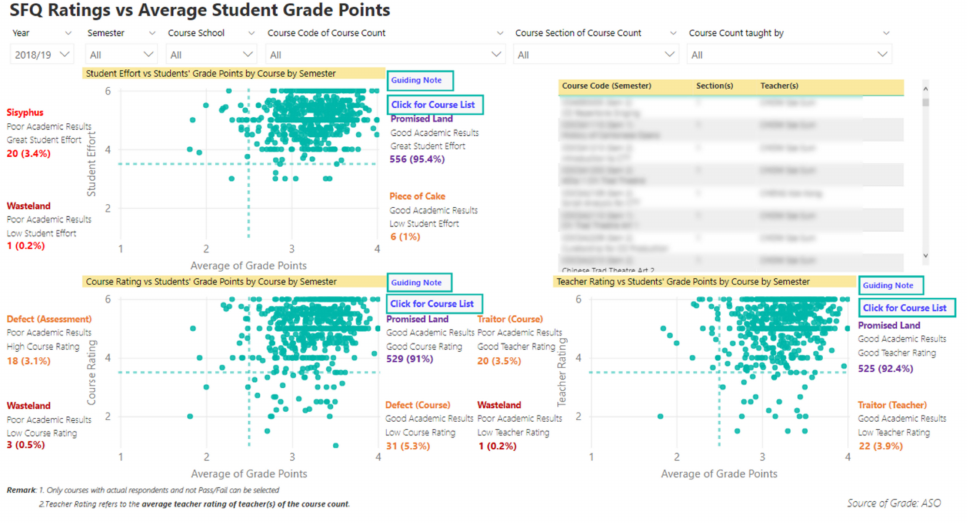
Figure 11. SFQ Ratings vs. Average Student Grade. Note: (1) In the visual “Student Effort vs. Students’ Grade Point”, each data point represents the average “Student Effort” rating given by students, and students’ grade for a particular course; (2) In the visual “Course Rating vs. Students’ Grade Point”, each data point represents the average course rating given by students, and students’ grade for a particular course; (3) In the visual “Teacher Rating vs. Students’ Grade Point”, each data point represents the average Teacher Rating given by students, and students’ grade for a particular